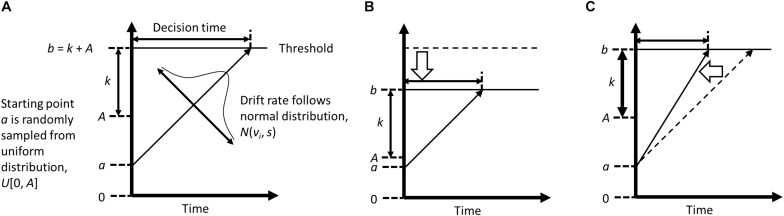
Conceptual diagrams of Liner Ballistic Accumulator model, created based on Brown and Heathcote (2008) and Annis et al. (2017). Panel (A) indicates a typical accumulation process that is assumed in a LBA model; Panel (B) (with a low threshold, caused by lower level of maximum starting evidence); and Panel (C) (with a high drift rate) illustrate the conditions where shorter response time is observed.